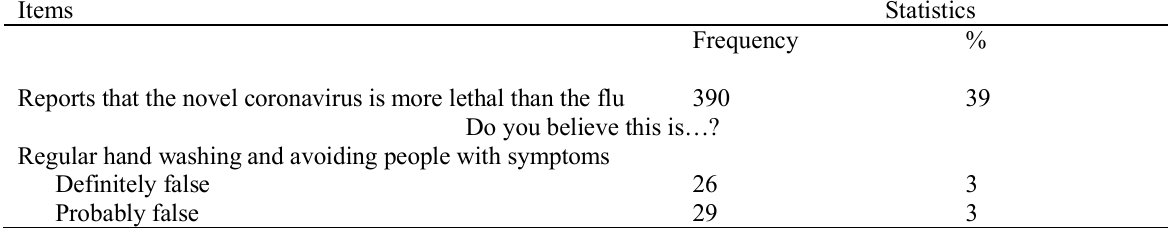
Table 1. Information, Misinformation, and Media